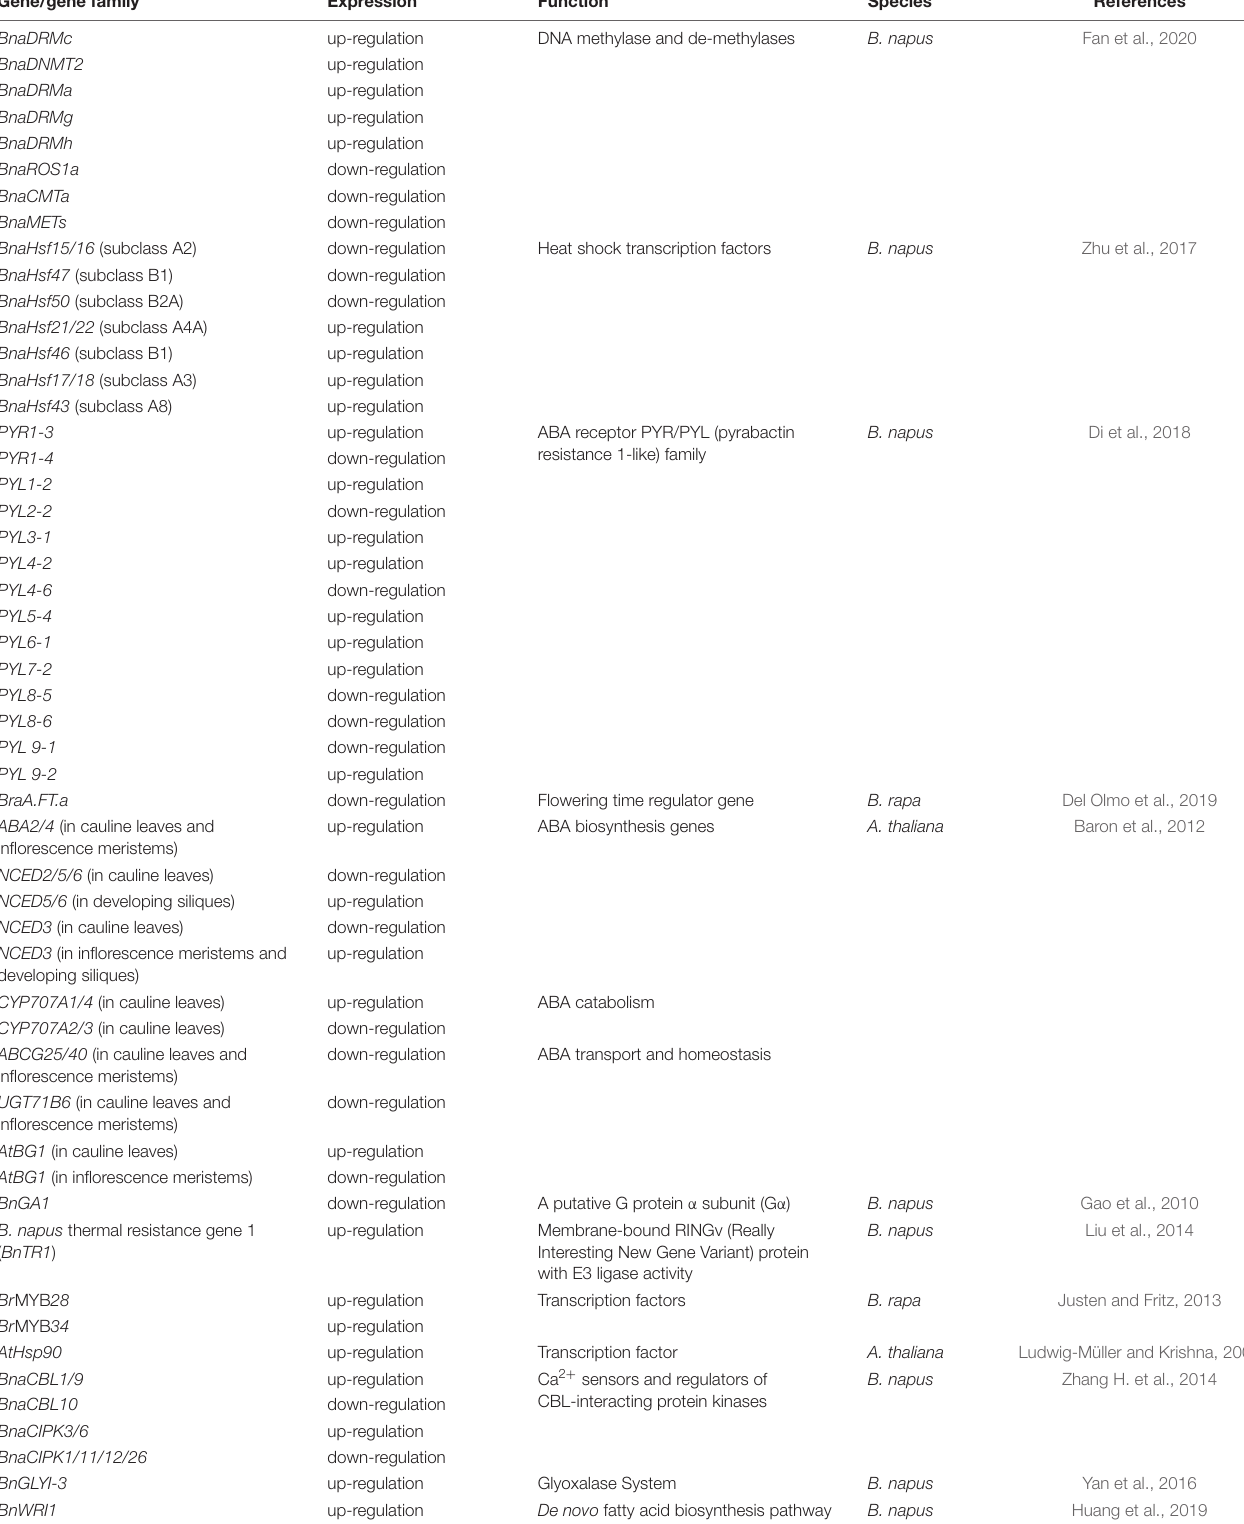
TABLE 1 | Heat stress responsive genes identified in Brassica napus and related species. Gene/gene family Expression